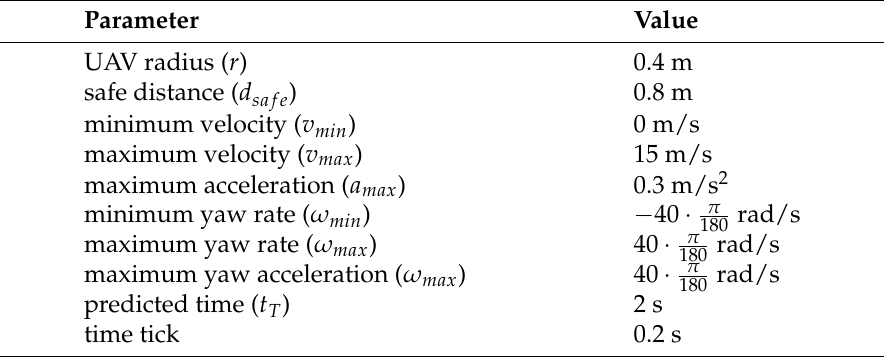
Table 1. Simulation parameters.